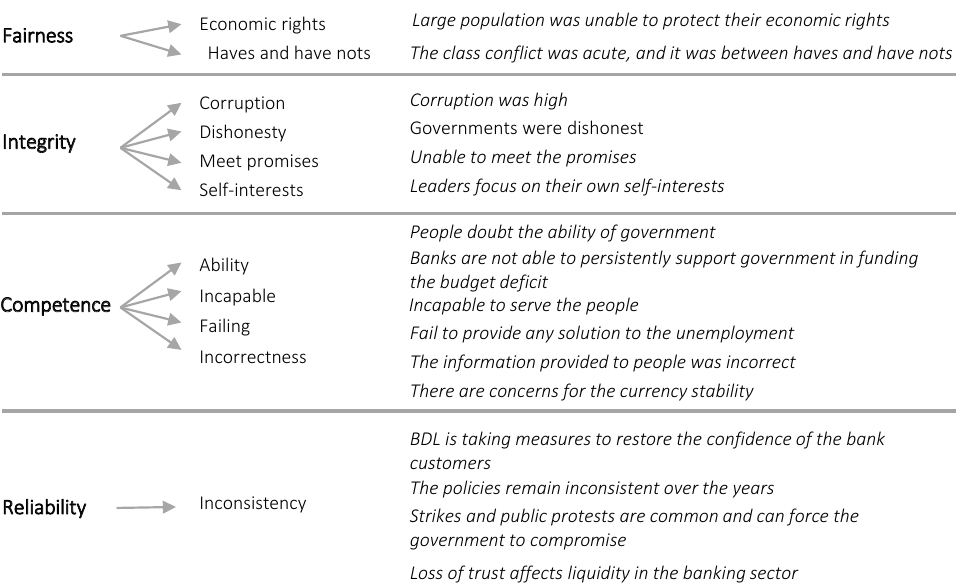
Figure 4. Thematic construct of Trust Deficit